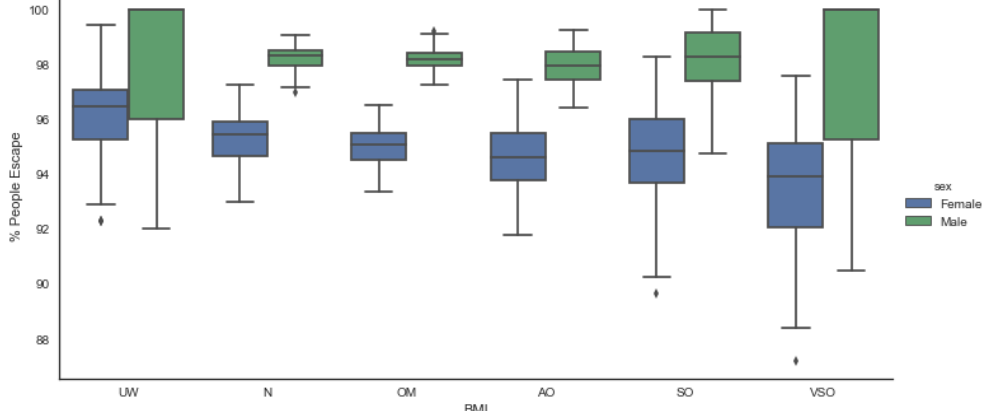
Figure 8. Evacuation times (People) classified by BMI.